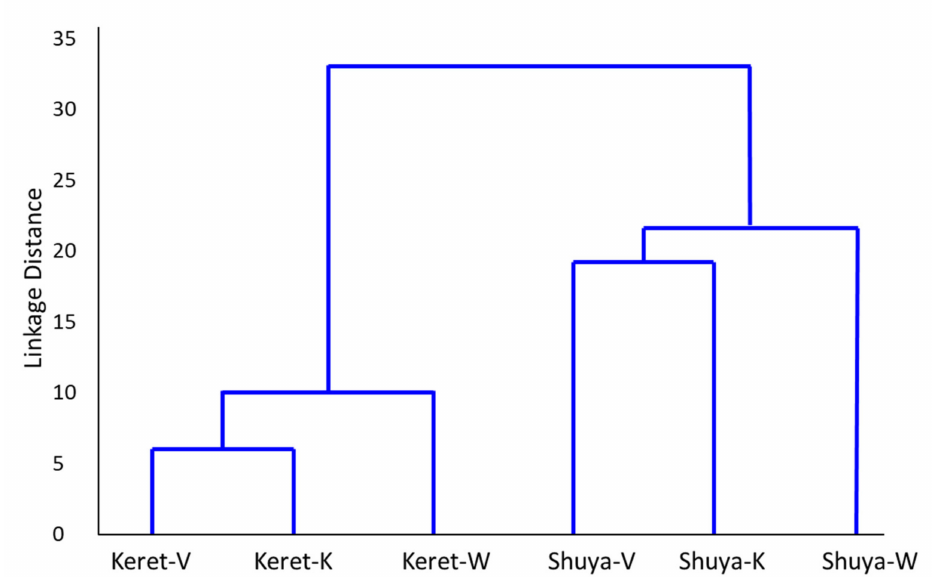
Figure 2. Clustering of the six juvenile Atlantic salmon samples by the 11 cranial bones indices. The measure of similarity is squared Euclidean distance, and the clustering algorithm is unweighted pair-group